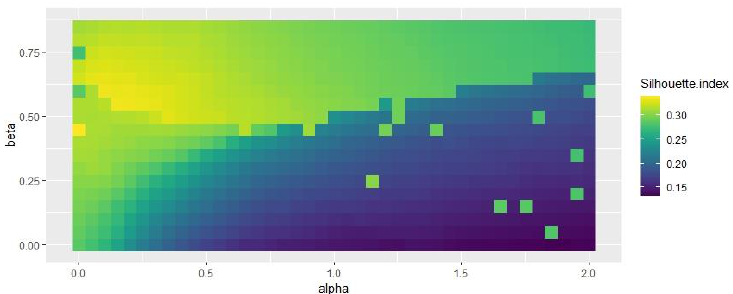
Figure 7. Influence of beta and alpha values on silhouette index.